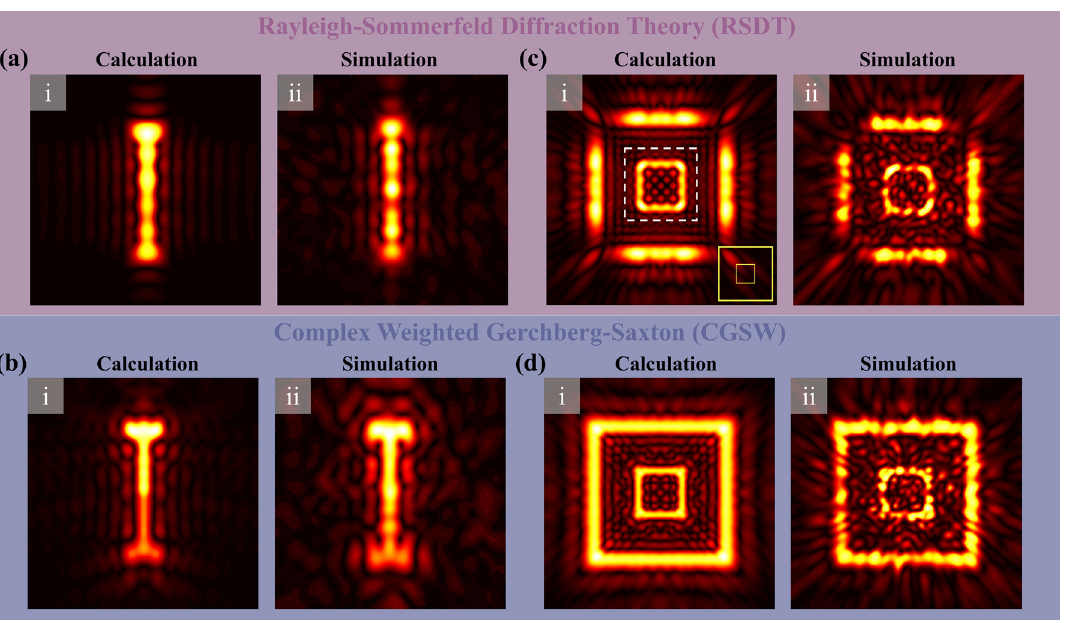
Figure 4: Simulation results of the image reconstruction by Rayleigh – Sommerfeld diffraction theory (RSDT) and complex weighted Gerchberg – Saxton (CGSW). (a)and(b)Calculatedandfull-wavesimulatedreconstructedimagesof “ I ” bymetasurfacesdesignedbyRSDTandCGSW.(c)and(d)Calculated and simulated reconstructed images of the concentric square boxes by metasurfaces designed by RSDT and CGSW. The white dotted square represents the outline of metasurfaces and the insert illustration shows the preset